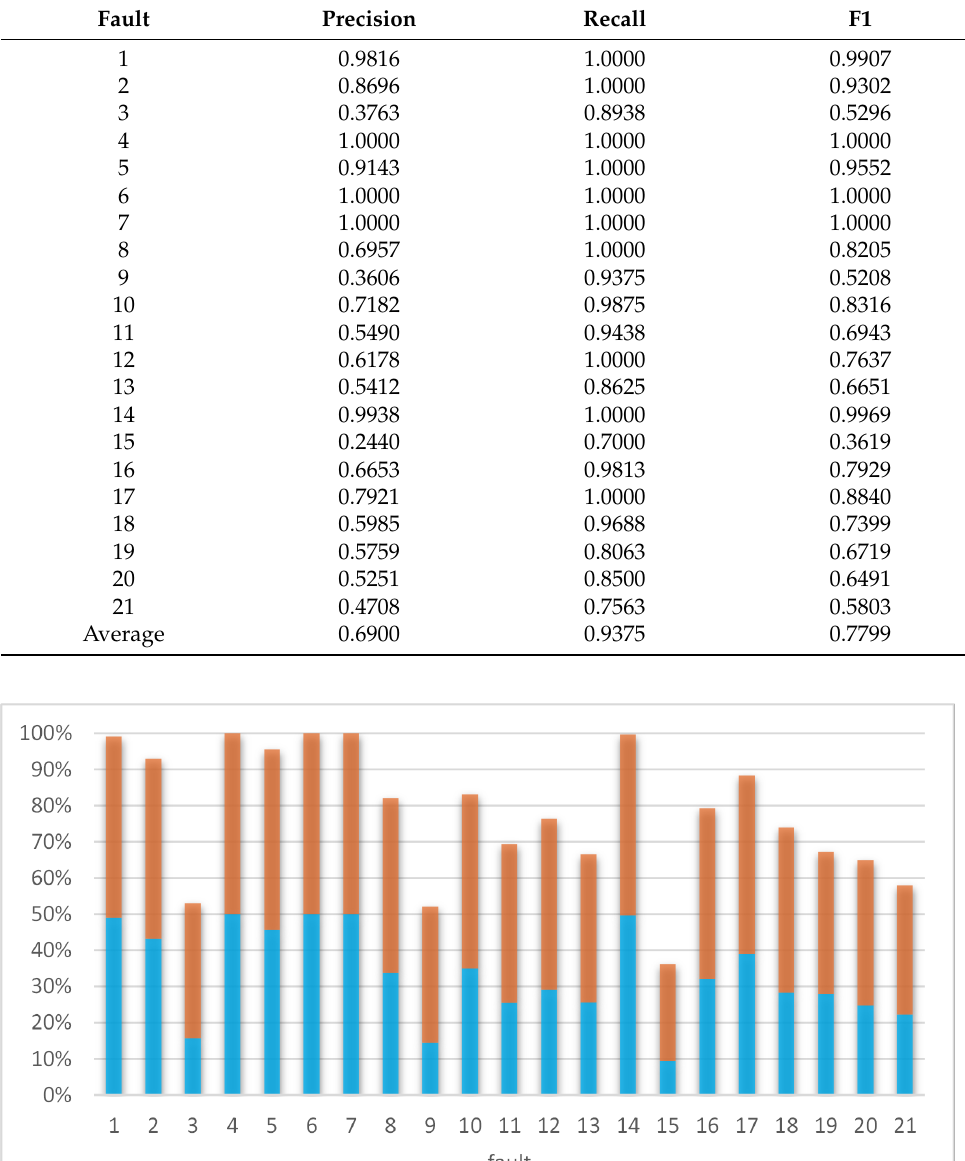
Table 5. F1-score of BCOA-KELM in TE process.